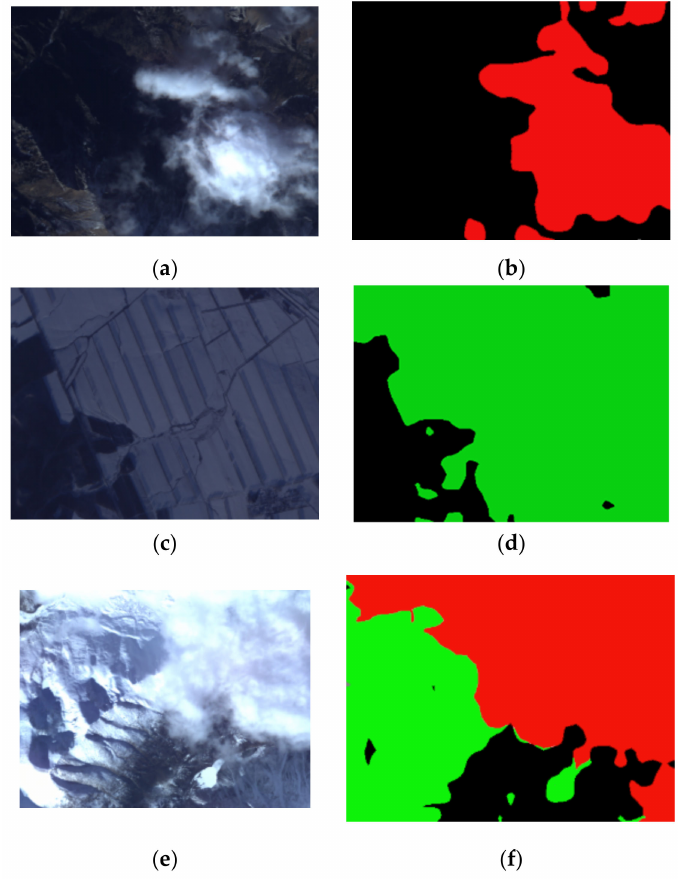
Figure 2. The coarse-labeled images and their masks. ( a ) Cloud; ( b ) mask; ( c )snow; ( d ) mask; ( e ) cloud and snow; ( f ) mask.